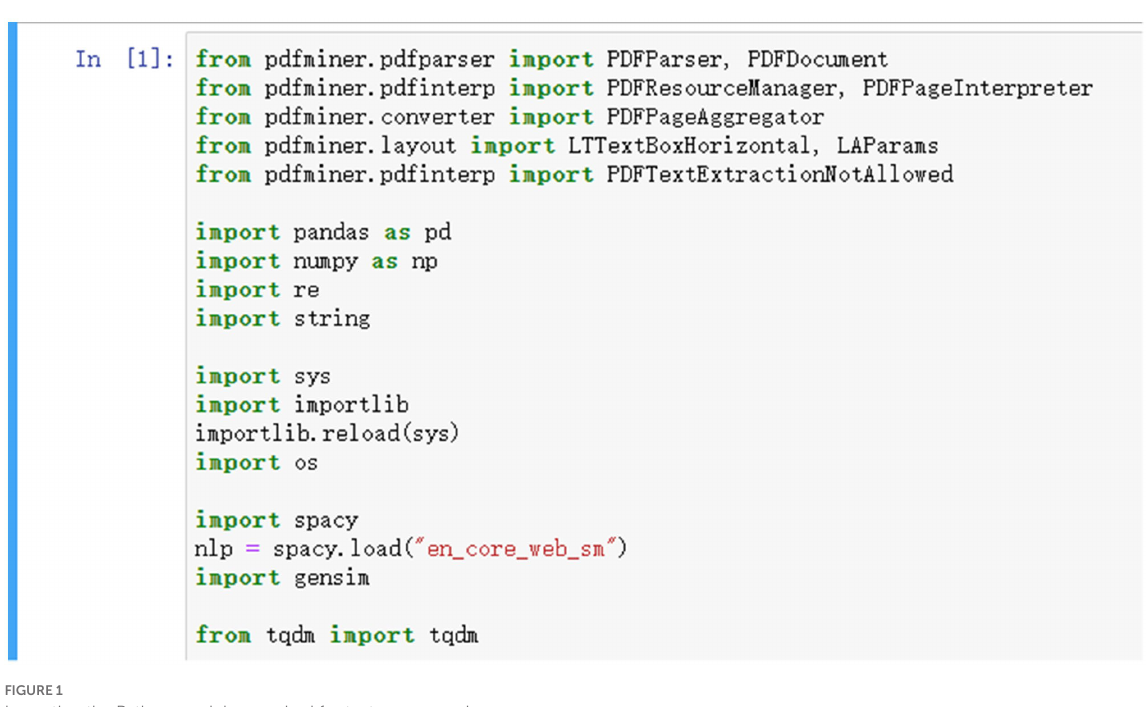
FIGURE 1 Importing the Python modules required for text preprocessing.